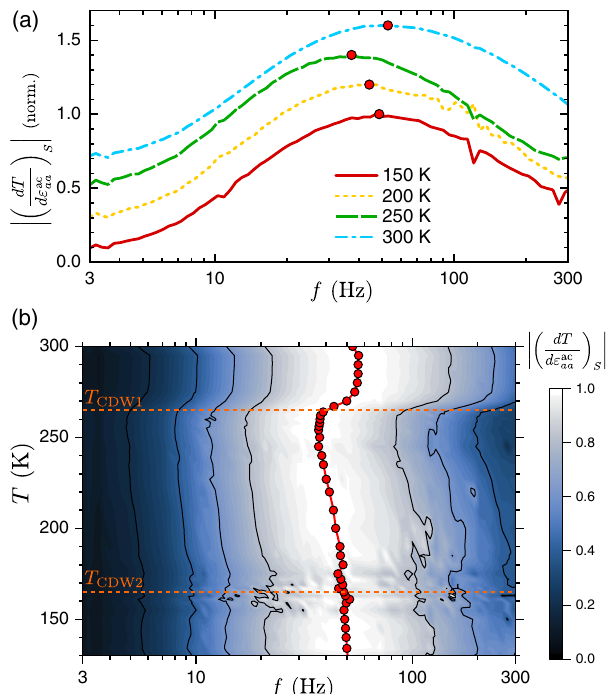
FIG. 12. Frequency dependence of elastocaloric effect mea- surements on ErTe 3 under a -axis stress. (a) Magnitude of the ECE signal as a function of strain frequency for several representative temperatures. Each curve is normalized to the maximum signal observed at that temperature, and the curves are vertically offset for clarity. The peak is notated with a red circle. Panel (b) shows similar data for a dense set of temperatures, presented as a contour plot. As the sample cools below T , the CDW 1 peak frequency decreases from approximately 55 Hz to approx- imately 35 Hz. This shift in the peak frequency reflects a sudden decrease in thermal conductivity. This is qualitatively consistent with the Wiedemann-Franz law: this measurement is most sensitive to the thermal conductivity along the a axis, and the electrical resistivity ρ also shows the highest increase when aa cooling through T . Data presented in the main text were CDW 1 acquired for a constant frequency in the range of 20 – 40 Hz. Shifts in the frequency dependence with temperature will affect the absolute magnitudes of the ECE signals in Figs. 3 and 4, but would alter neither qualitative behavior nor the conclusions stemming from this